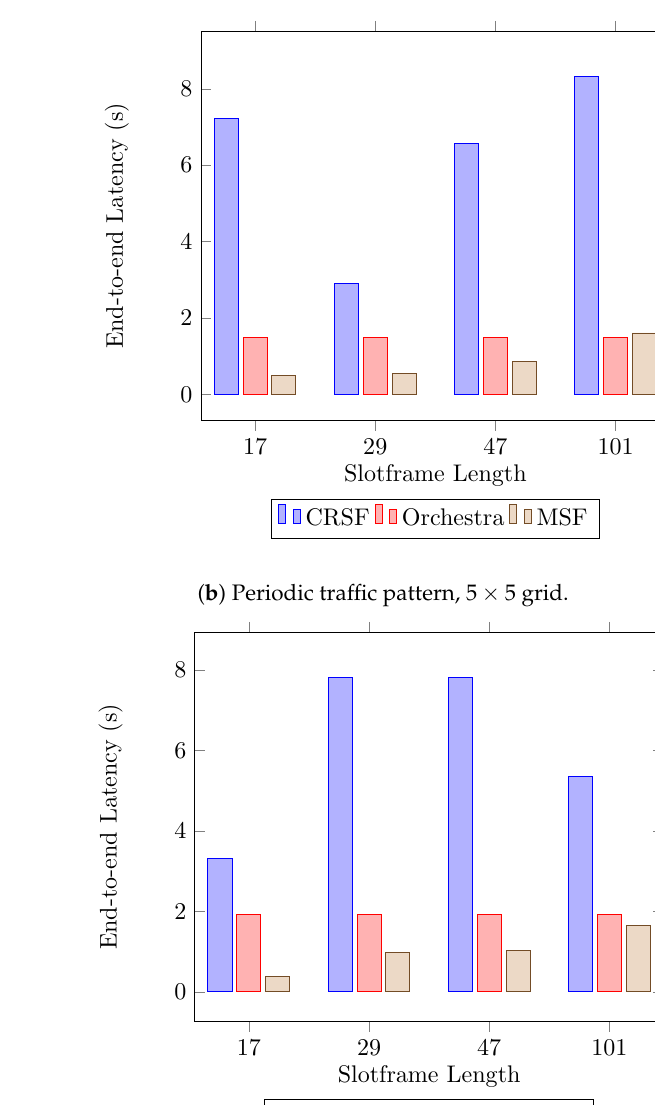
( a ) Periodic traffic pattern, 4 × 4 grid. ( b ) Periodic traffic pattern, 5 × 5 grid.